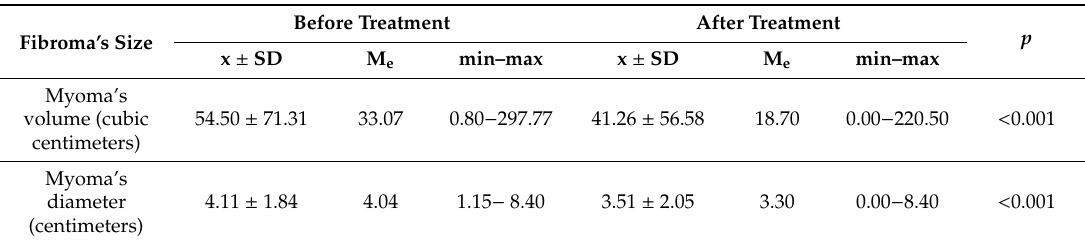
Table 1. The diameter and volume of fibroids before and after 3 months of treatment with ulipristal acetate ( n = 34 patients).